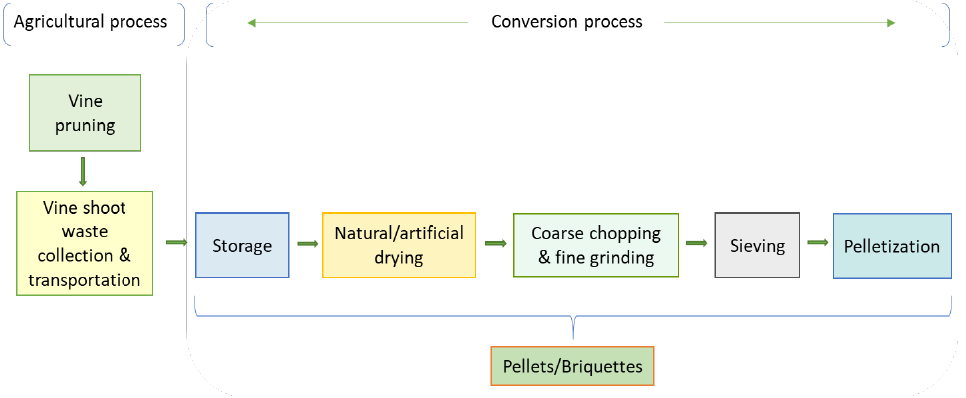
Figure 2. System boundary for the vine shoot waste to pellets/briquettes scenario.